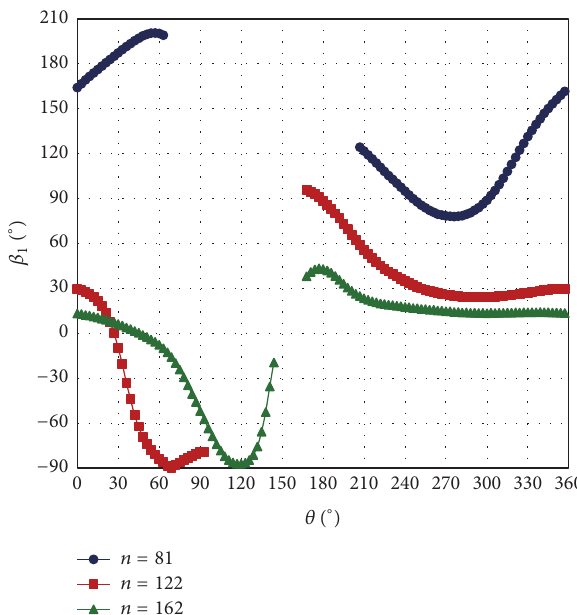
Figure 13: Relative flow angle at runner inlet (Cal.).